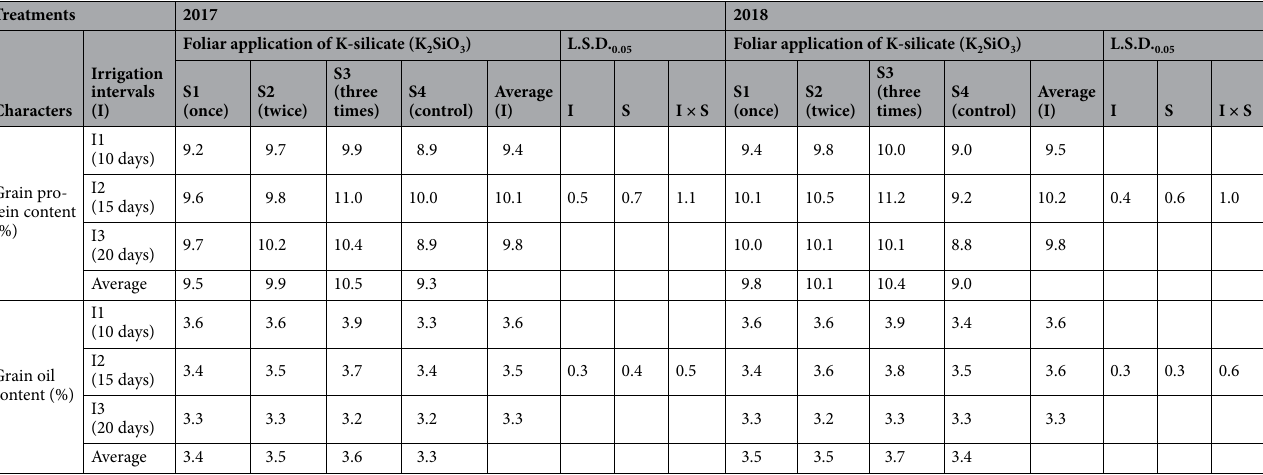
Table 4. Grain protein content (%) and content oil (%) of maize as affected by irrigation intervals and foliar application of K-silicates in the 2017 and 2018 seasons. I1, I2, and I3: irrigation intervals treatments; S1,S2, S3 and S4: foliar application of K-silicate treatments; L.S.D.at 5%, the least significant difference at a 5% level of